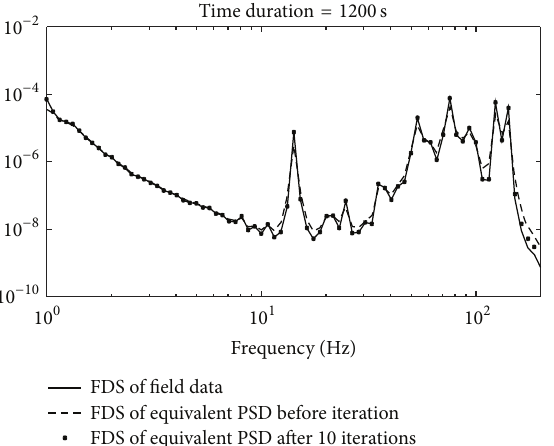
Figure 15: The FDS of the field data and the equivalent PSD ( 𝑇 = 1200 s).